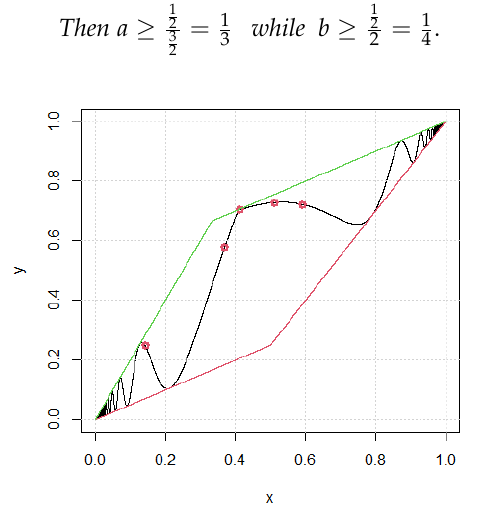
Figure 4. Example